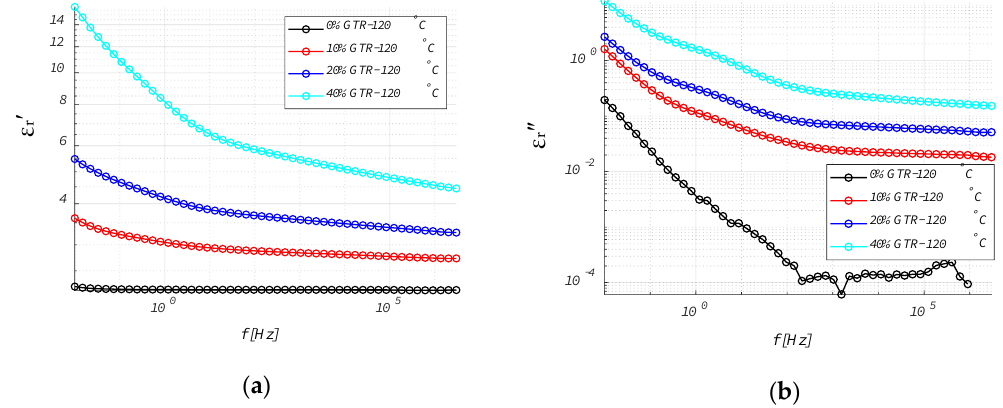
Figure 6. Real ( a ) and imaginary ( b ) dielectric permittivity of HDPE/GTR, at 120 °C, in relation to frequency: HDPE; HDPE + 10% GTR; HDPE + 20% GTR; HDPE + 40% GTR.